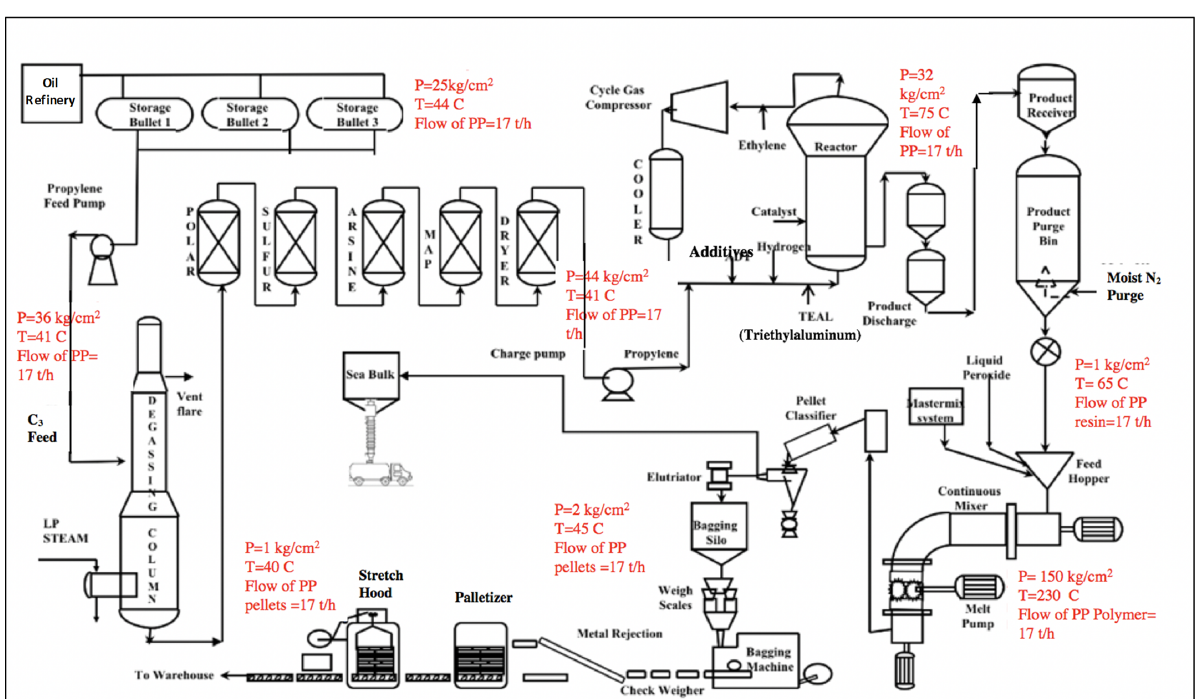
Figure 2. Process flow diagram of the PP manufacturing process obtained from an existing plant in the GCC.